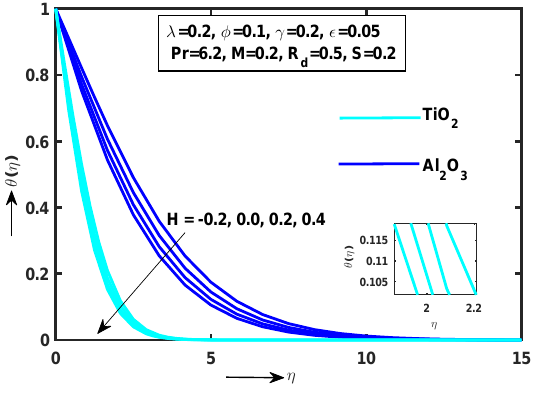
Figure 7: Significance of H on θ ( η )